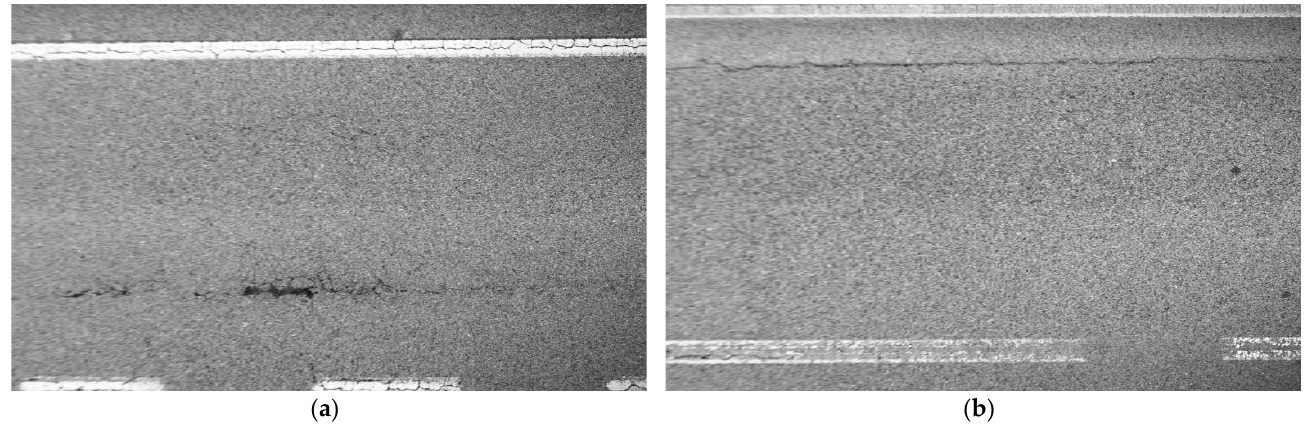
Figure 20. Correct classifications performed by the classification model: ( a ) image from section [76,200; 76,300] with a longitudinal crack in the pavement surface and within the white lane markings (the system classified the image as longitudinal crack); ( b ) image from section [76,900; 77,000] with a longitudinal crack in the pavement surface (the system classified the image as longitudinal crack).